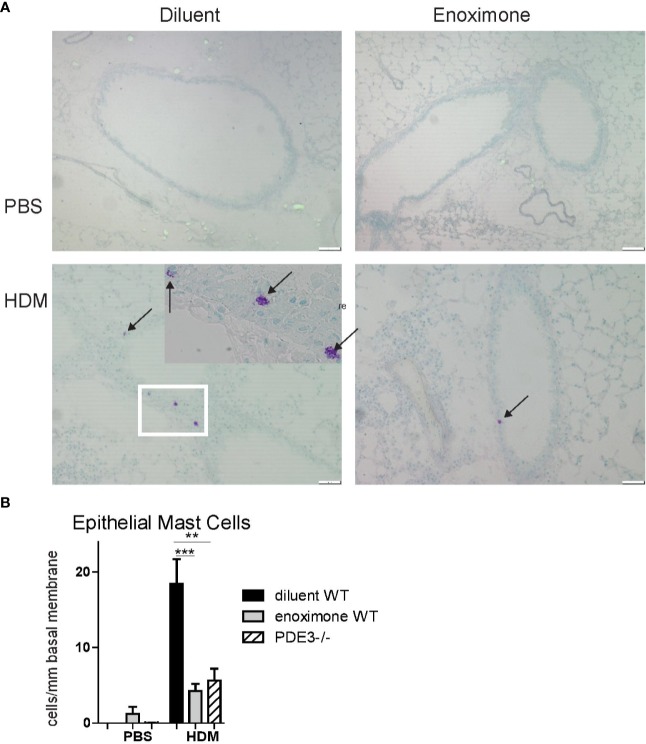
Mast cell recruitment is impaired when PDE3 is targeted. (A) Representative photographs of toluidine blue (arrows pointed to mast cells) stained lung section obtained from phosphate buffered saline (PBS) control mice and house dust mite (HDM) driven asthmatic mice. (B) Number of epithelial mast cells (MCs) per mm length basal membrane. A Kruskal-Wallis test for multiple comparisons was used, followed by a Mann-Whitney U test. Error bars show mean values ± SEM (n=3 for PBS, n=6 for HDM groups; **P < 0.01; ***P < 0.005). Data are representative for three independent experiments.